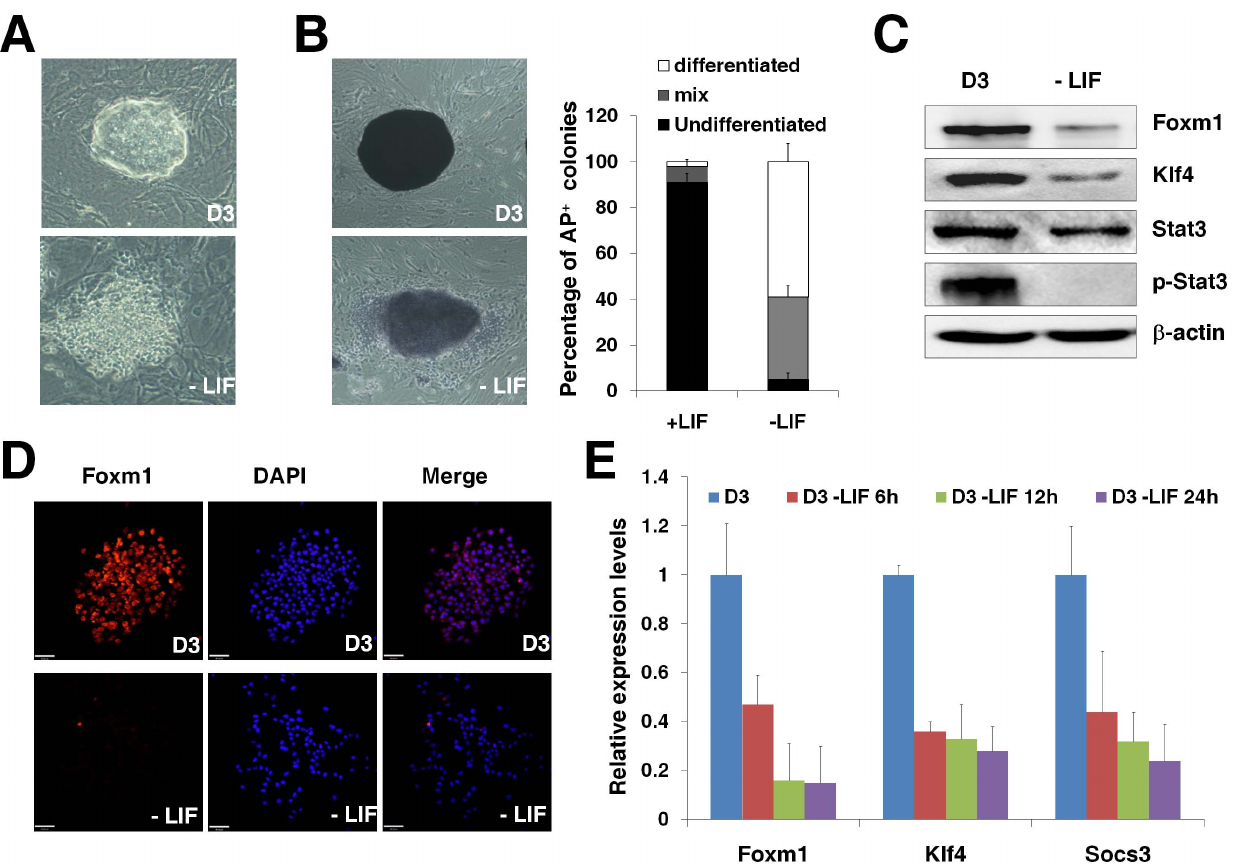
Figure 1. LIF signaling pathways maintain the expression of Foxm1 in mESCs. (A) D3 ES cells were cultured in the presence of feeders without LIF for one week. In the absence of LIF, D3 ES cells lost the typical colony morphology. The control D3 ES cells and D3 ES cells without LIF were cultured under exactly the same conditions for one week without replating. (B) Alkaline phosphatase staining and quantification of differentiated, mix, or undifferentiated colonies of D3 ES cells and D3 ES cells without LIF for one week. Error bars indicated standard deviation (n=3). (C) The withdrawal of LIF resulted in the decreased levels of Foxm1 protein in D3 ES cells. Western blot analyses were performed for the expression of Foxm1, Klf4, Stat3, phosphorylated Stat3 (p-Stat3), and b -actin in D3 ES cells or D3 ES cells without LIF for two days. (D) Immunostaining of Foxm1 in D3 ES cells or D3 ES cells without LIF for one week in the presence of feeders. Pictures were taken with the UltraVIEW VoX Spinning Disk Confocal Microscope (Bar=50 m m). (E) LIF withdrawal resulted in a rapid decrease of Foxm1 mRNA in D3 ES cells. Quantitative RT-PCR analyses were performed for Foxm1, Klf4, and Socs3 mRNA levels in D3 ES cells or D3 ES cells at 6 h, 12 h, and 24 h post LIF withdrawal. The mRNA levels of each transcript in D3 ES cells with LIF were set at 1.0. Error bars indicated standard deviation